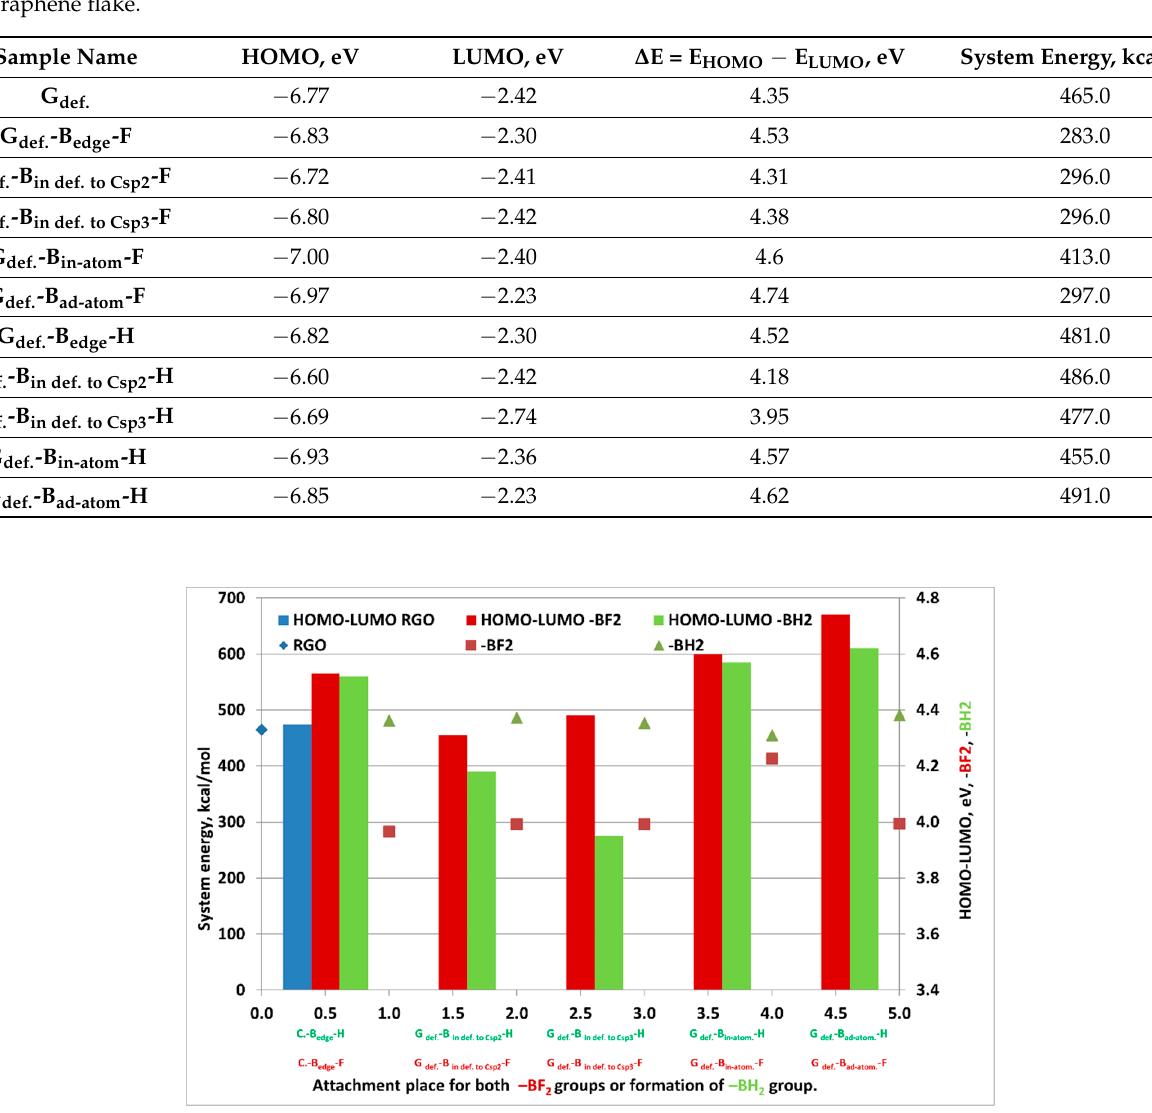
Figure 1. Analysis of the energy value of graphene systems depending on the place of attachment of -BF 2 groups or the formation of -BH 2 groups, respectively, from the left: on the edge of the flake (1), in the area of the defect in the form of vacancy of 1 C atom to carbon with sp 2 (2) or sp 3 (3) hybridization, either in-atomically for carbon sp 2 hybridizing the graphene structure (4) or ad-atomically (5) with respect to the unmodified, defective graphene